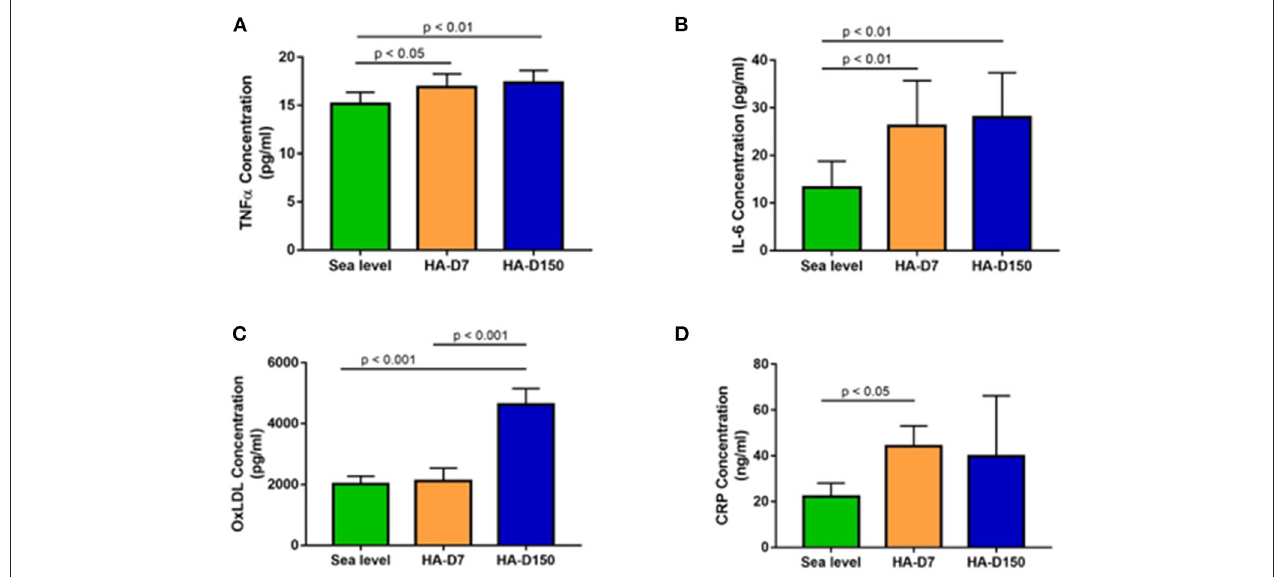
FIGURE 3 | Assessment of inflammatory cytokines in the study groups ( n = 8). ELISA-based estimation of (A) TNF- α , (B) IL-6, (C) ox-LDL, and (D) CRP for sea level, HA-D7, and HA-D150 groups.